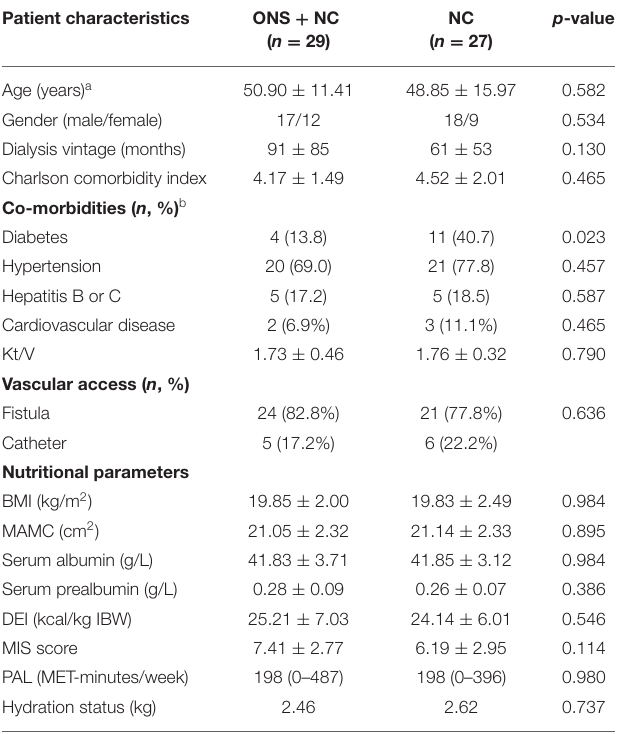
TABLE 1 | Baseline characteristics of study patients. Patient